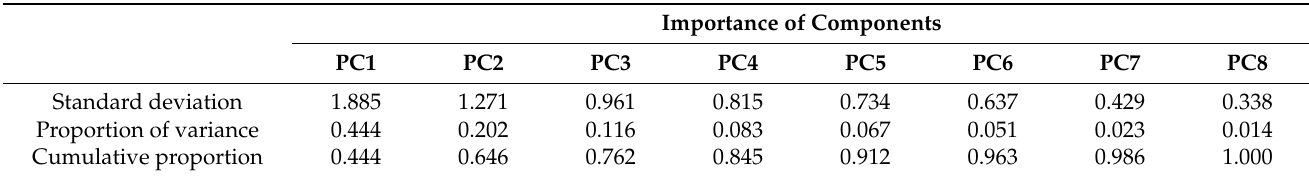
Table A2. Results of principal component analysis (PCA) of relative plasma levels of eight miRNAs potentially related to CAD.